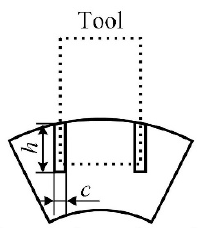
Figure 9. A schematic of mixed fracture modes involved during the cutting process [21].